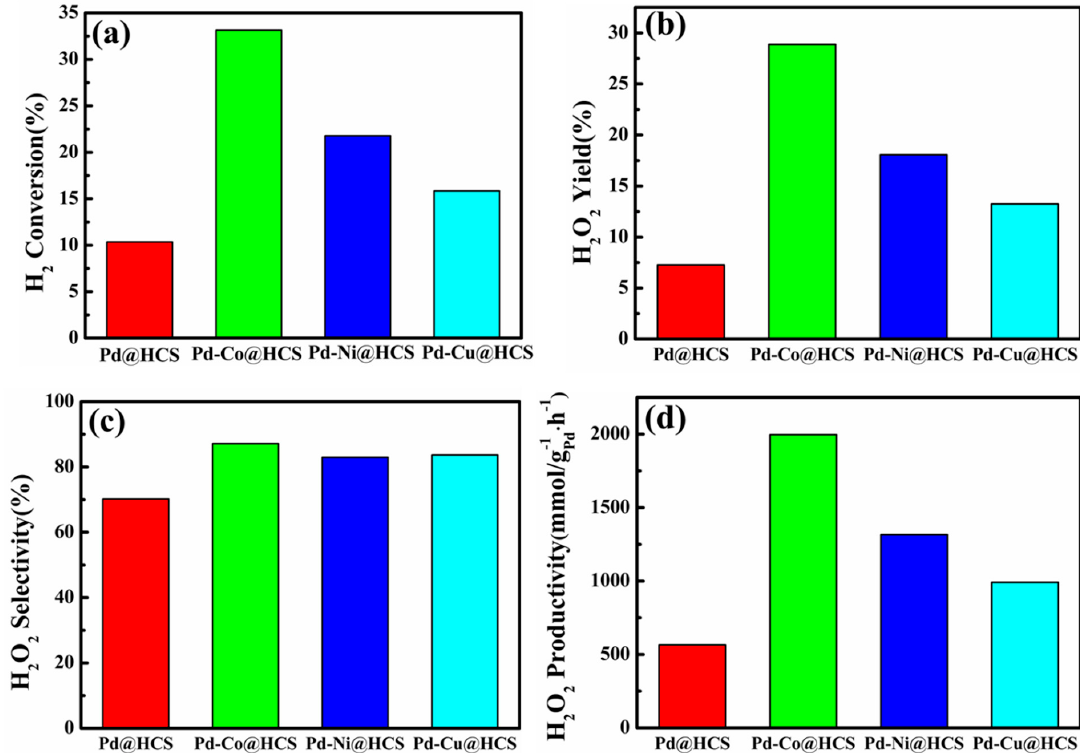
Figure 4. Catalytic activity of the prepared catalysts Pd@HCS and Pd-M@HCS. ( a ) H 2 conversion, ( b ) H 2 O 2 yield, ( c ) H 2 O 2 selectivity, and ( d ) H 2 O 2 productivity.